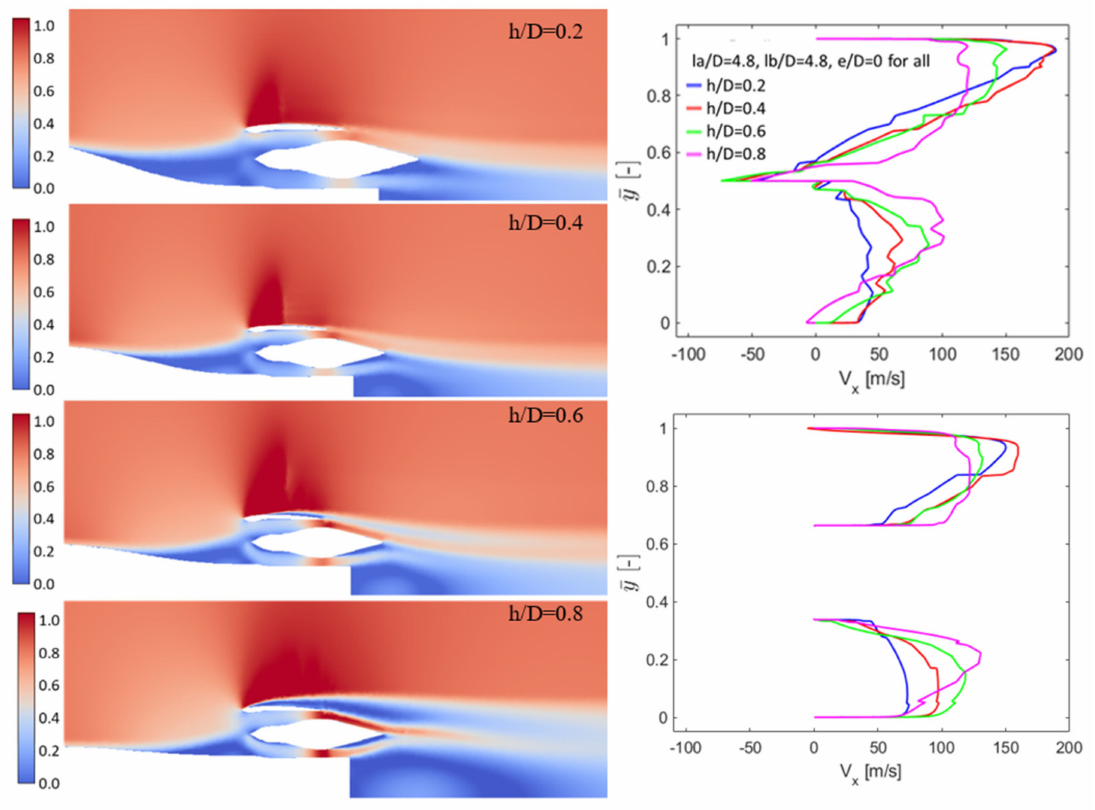
Figure 8. Contours of Mach number for varying nacelle highlight positions, 2D